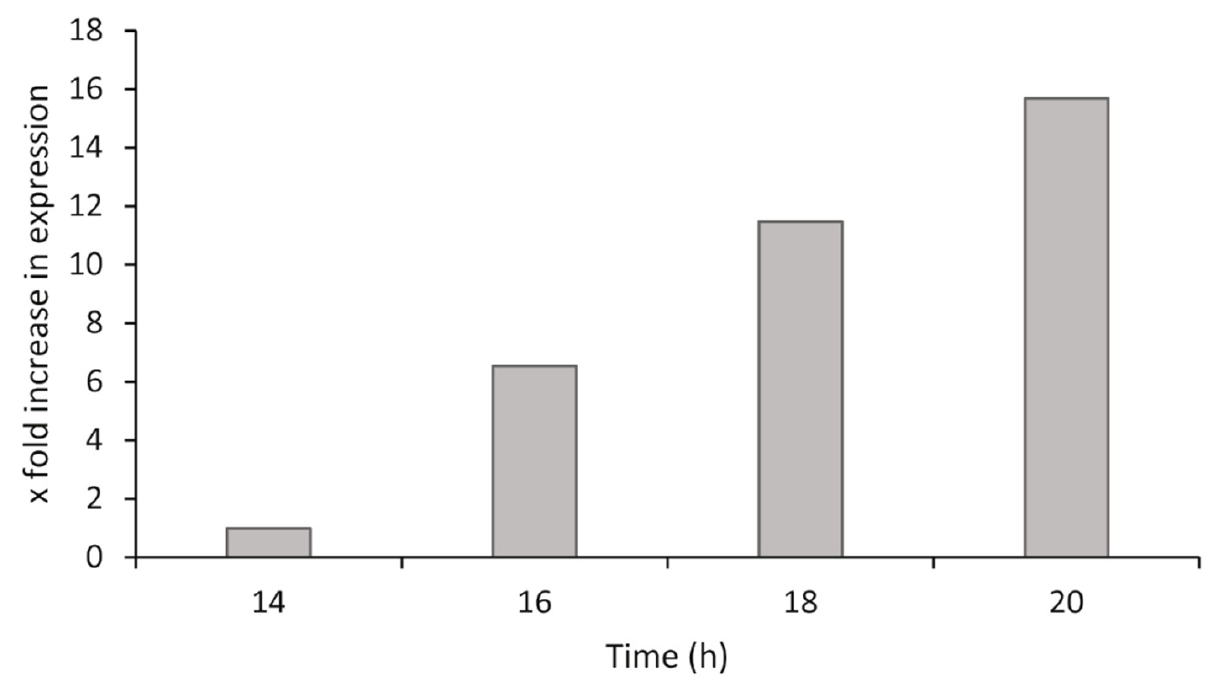
Figure 5. Expression levels of < hia > in P. atlantica (UiBP1-2013) during growth in liquid medium. The time period corresponds to the exponential growth phase of the bacteria.